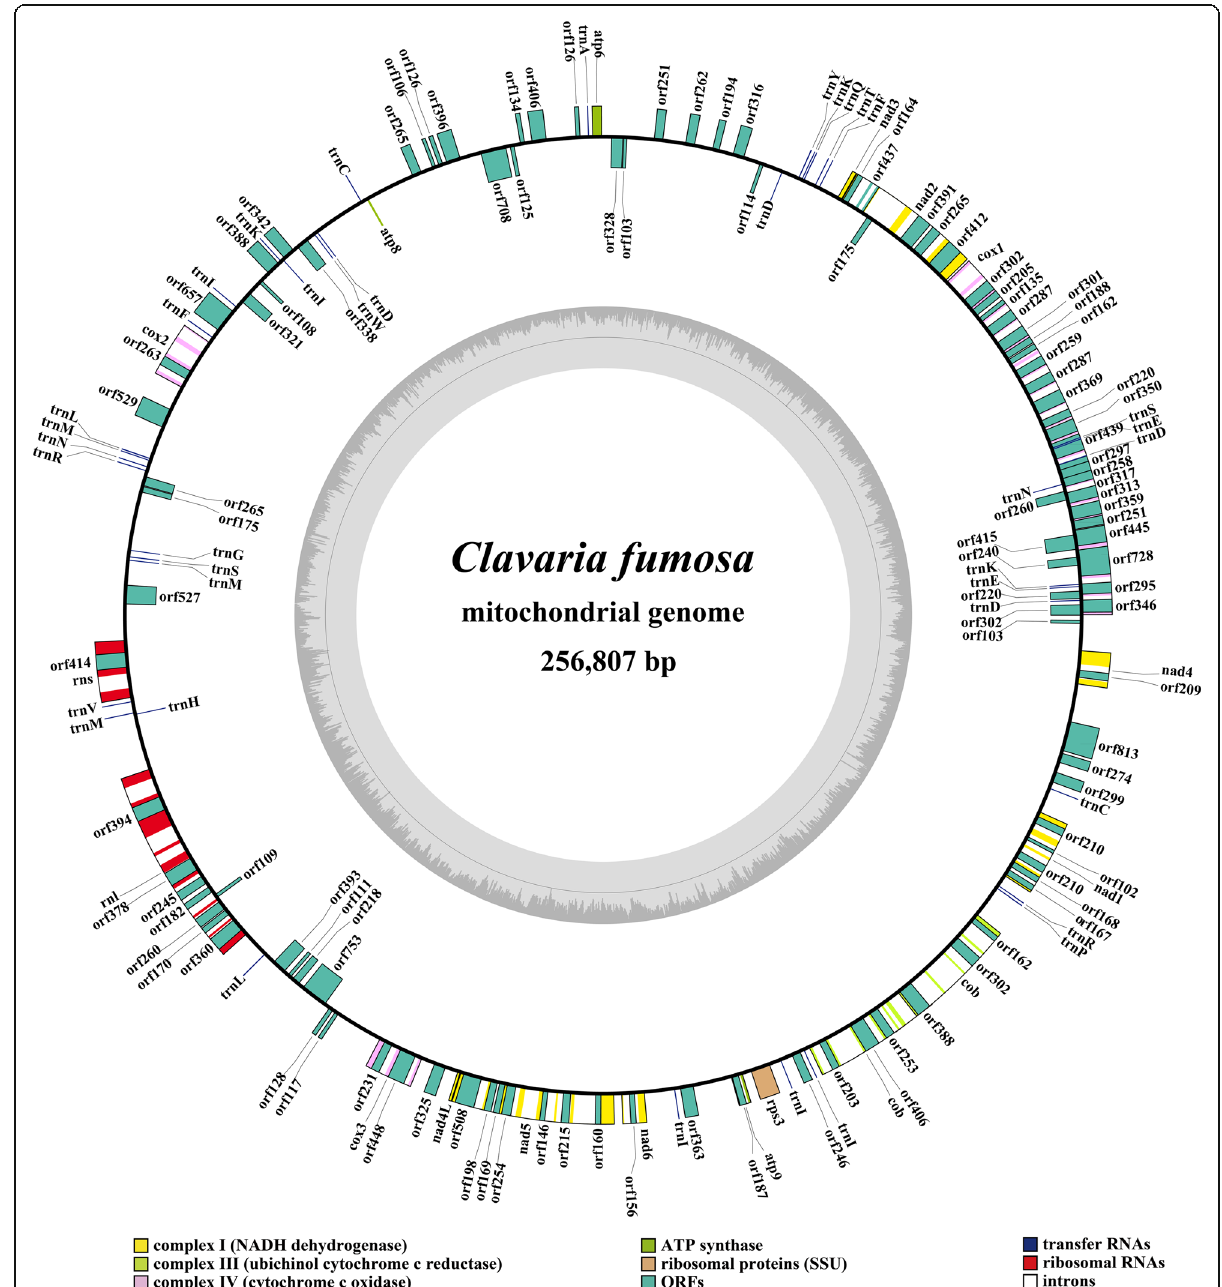
Fig. 1 Circular map of the mitochondrial genome of Clavaria fumosa . Genes are represented by different colored blocks. Colored blocks outside each ring indicate that the genes are on the direct strand, while colored blocks within the ring indicates that the genes are located on the reverse